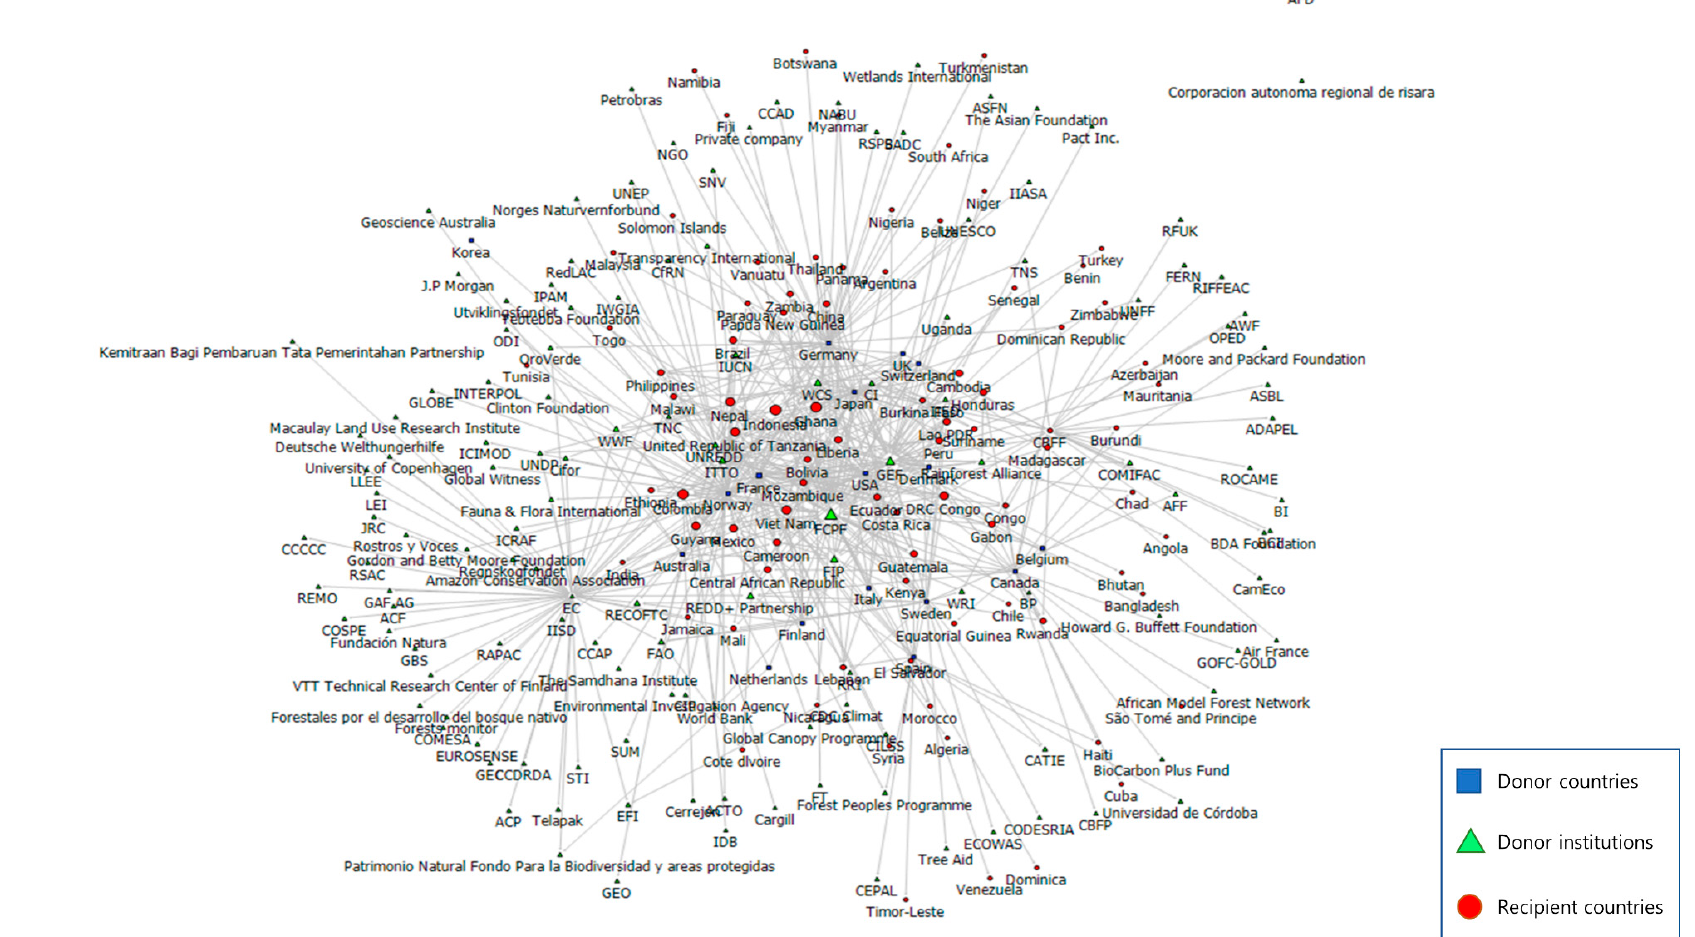
Figure 4. In-degree centrality in global REDD+ financial network in 2011.